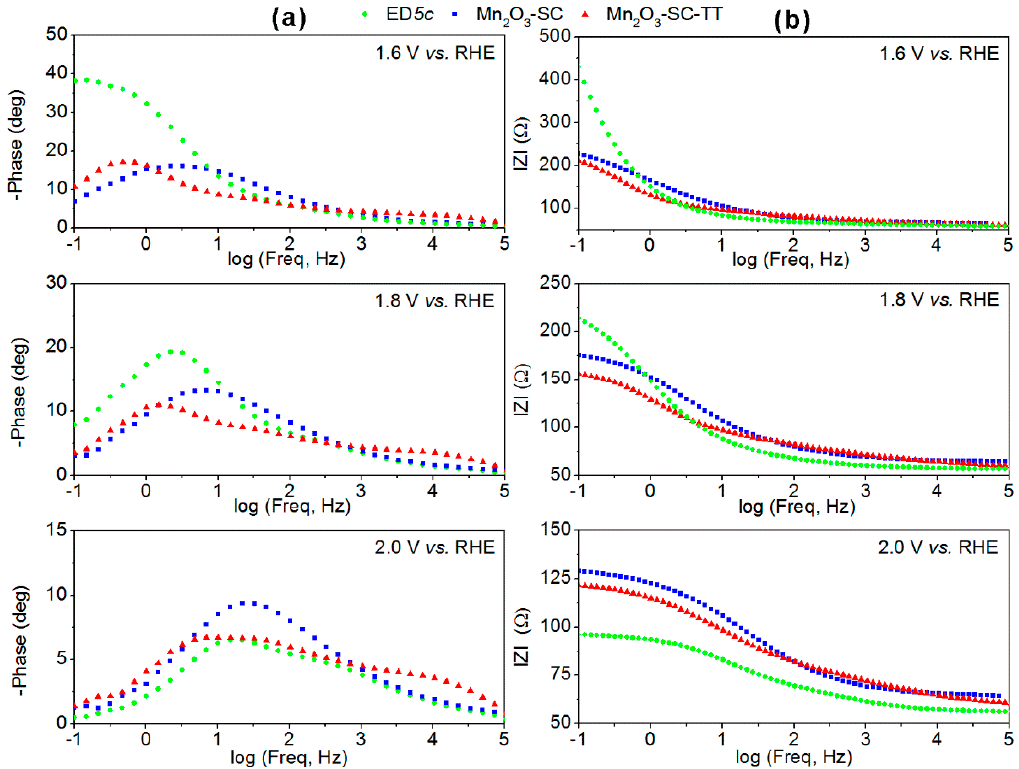
Figure 5. Bode plots representing ( a ) phase and ( b ) module of impedance acquired during EIS measurements by using the α -Mn 2 O 3 -based electrodes at 1.6, 1.8 and 2.0 V vs. RHE.